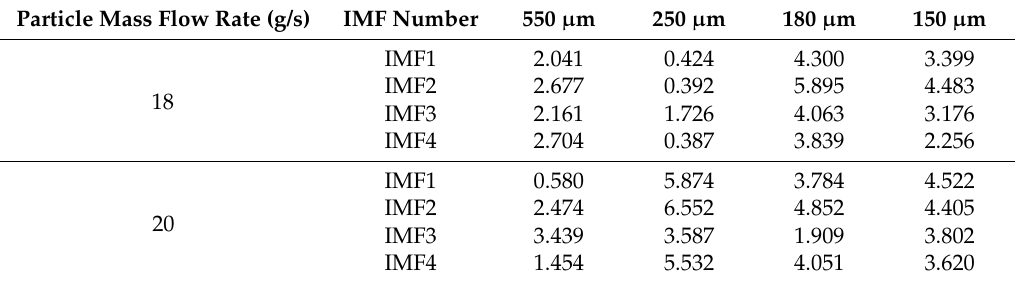
Table 3. Relative deviation for the validation